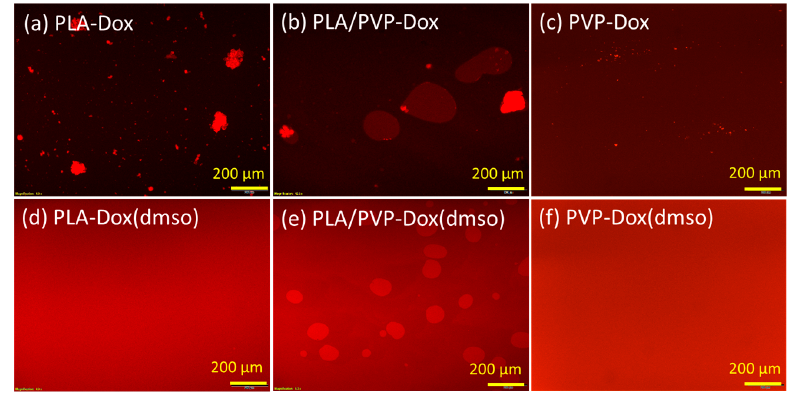
Figure 3. Fluorescence microscopy images of PLA-doxorubicin hydrochloride (Dox), PLA- Dox(dimethyl sulfoxide (DMSO)), PLA/PVP-Dox and PLA/PVP-Dox(DMSO) pre-spinning solutions casted on glass slides.